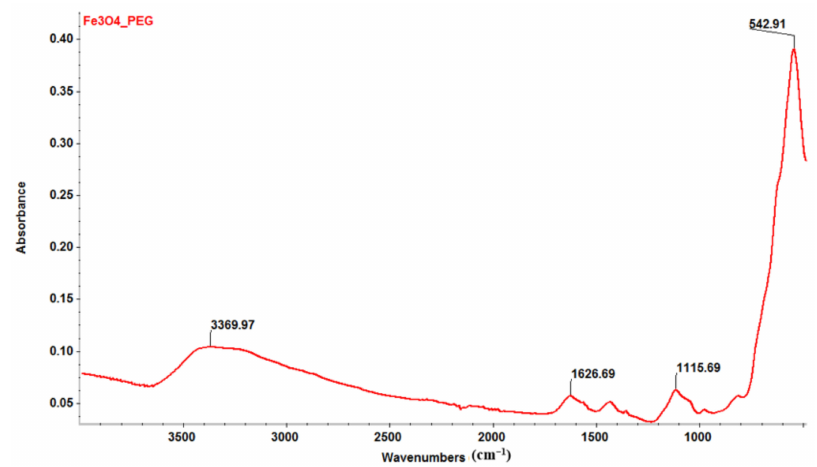
Figure 3. FT-IR spectrum of Fe 3 O 4 @PEG/PM nanoparticles.